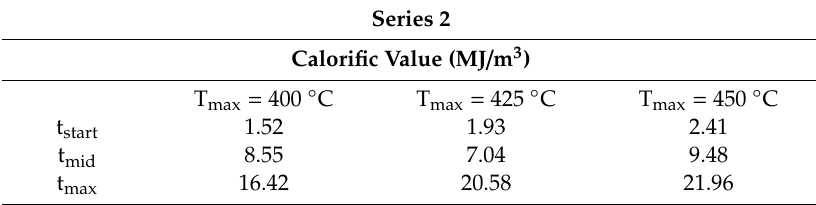
Table 9. Calorific value of the process gases at di ff erent temperatures, series